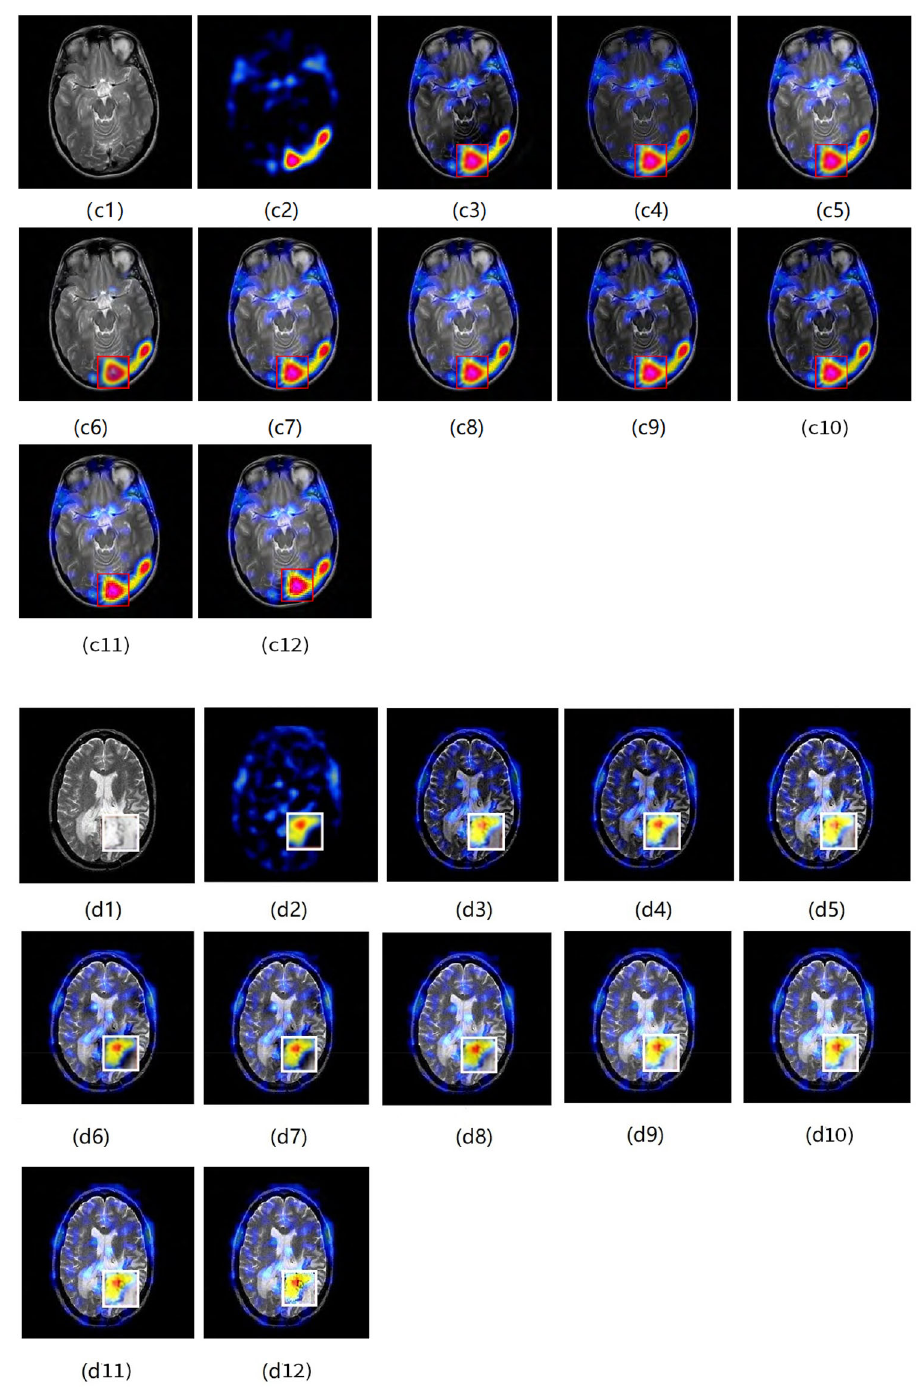
Fig. 5 Fusion results of two sets of MRI–SPECT images using different algorithms. c3 – c12 , d3 – d12 , respectively, denote the fused images of the LP–ASR, SR–NSCT, IOI–LLF,